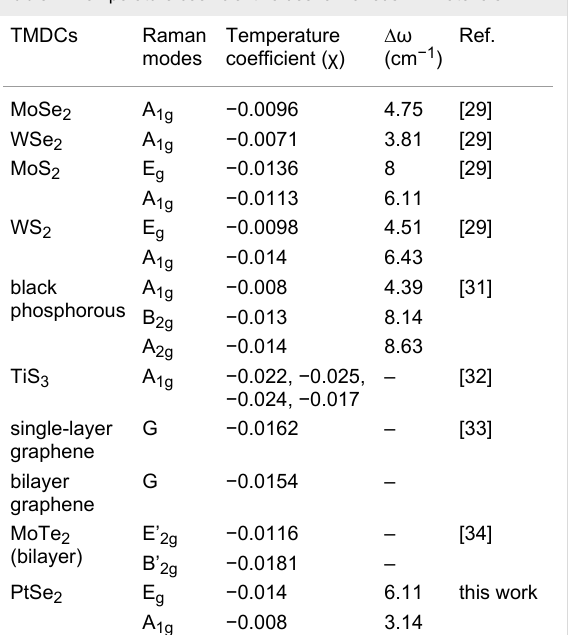
Table 2: Temperature coefficient values for various 2D